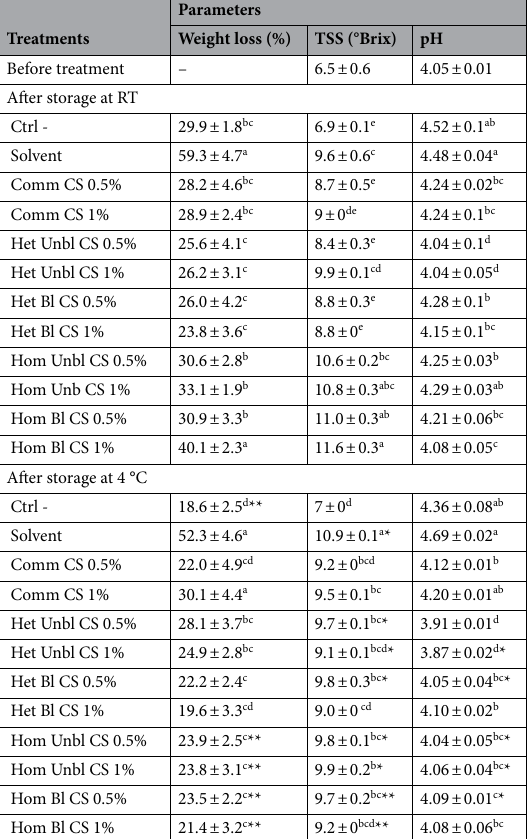
Table 3. Results of evaluation of weight loss, total soluble solids (TSS) and pH on whole tomatoes, coated by spraying, after 30 days of storage at room temperature (RT) and 4 °C. Treatments: untreated fruits (Ctrl-), solvent only, coating with heterogeneous unbleached (Het Unbl CS), heterogeneous bleached (Het Bl CS), homogeneous unbleached (Hom Unbl CS), homogeneous bleached (Hom Bl CS) and commercial (Comm CS) chitosan. Means followed by different letters in the column are significantly different by Mann–Whitney U test (p < 0.05). Each trial contained three triplicates of whole tomatoes per each treatment. Asterisks indicate significant differences (*p < 0.05; **p < 0.01) between the two storage temperatures within the same treatment, according to Mann–Whitney U